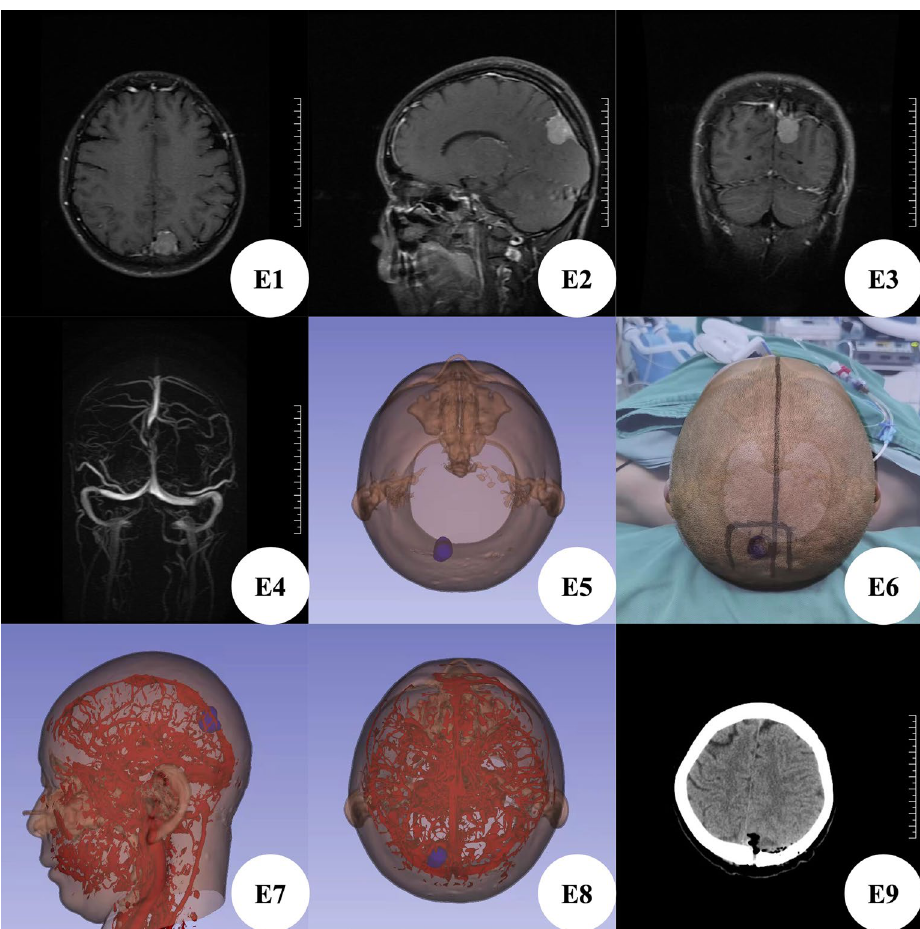
Figure 5. ( E1–E3 ) Brain MRI enhancement showed left parietal meningioma; ( E4 ) brain MRV showed that the posterior part of intracranial superior sagittal sinus became narrower; ( E5 ) 3D Slicer was used to reconstruct the left parietal meningioma image; ( E6 ) the Apple mobile phone APP MosoCam was used to design the left parietal space occupying projection and surgical incision; ( E7,E8 ) 3D Slicer was used to reconstruct the image of the relationship between intracranial vessels and left parietal meningioma; ( E9 ) postoperative brain CT showed that the tumor was resected cleanly without delayed